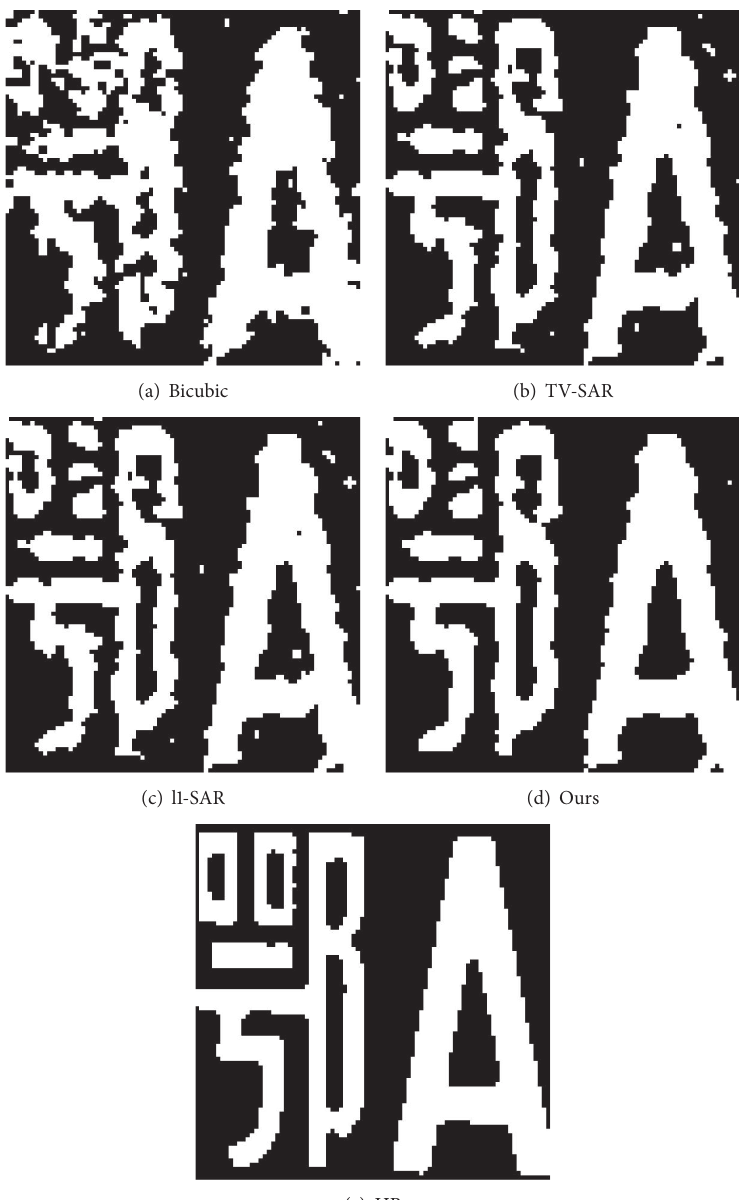
Figure 10: Binary results corresponding to Figure 9.